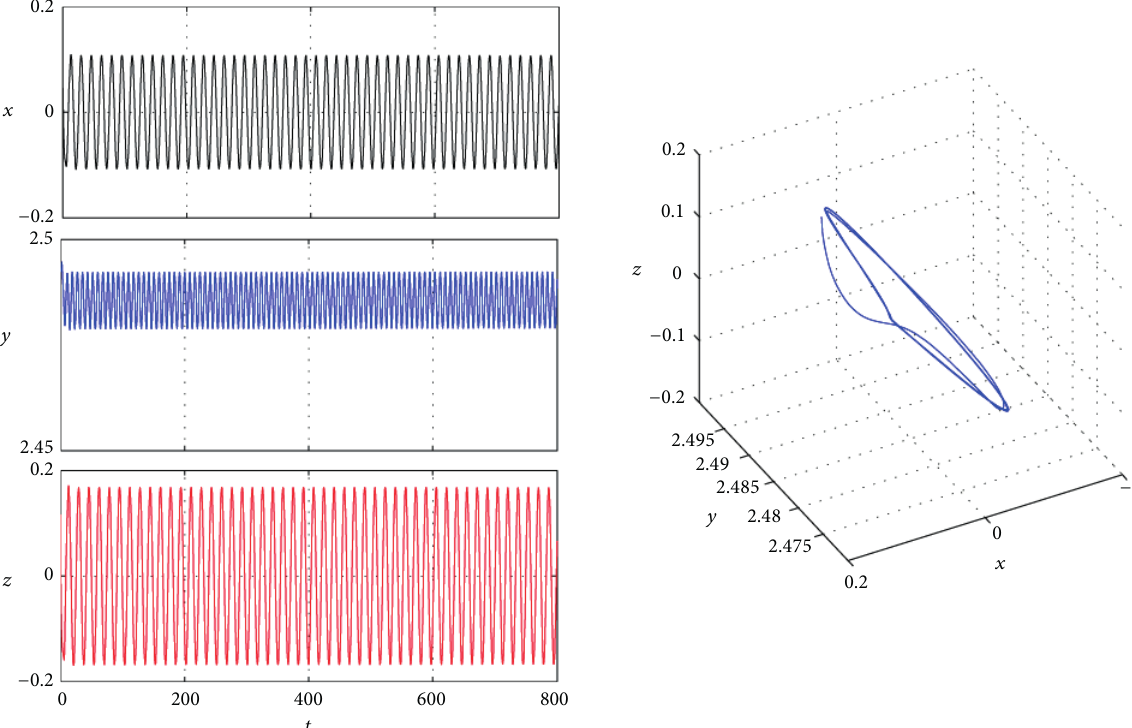
Figure 2: Trajectories 𝑥(𝑡) , 𝑦(𝑡) , and 𝑧(𝑡) and phase graphs of system (4) with 𝑎 = 4 , 𝑏 = 0.4 , 𝑐 = 1 , 𝑘 = 1 , 𝑑 = 1 , and 𝜏 = 5.5940